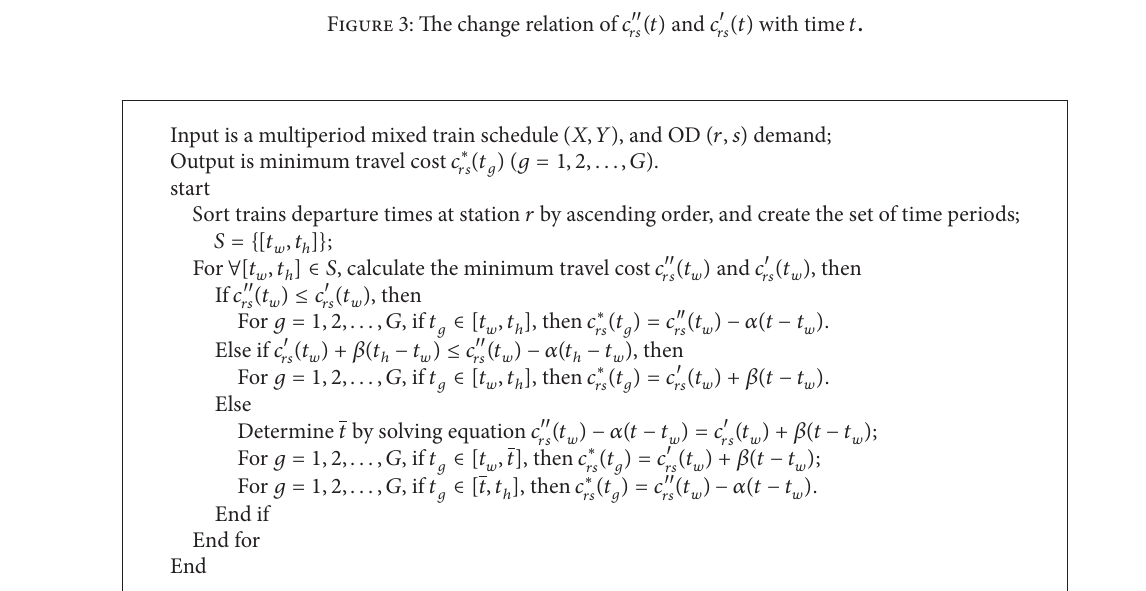
Algorithm 1: Calculating the minimum travel cost of OD ( 𝑟,𝑠 )